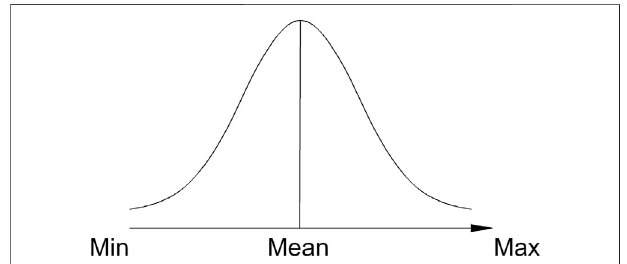
FIGURE 4 | Representation of novelty as a subjective dimension from a minimum (Min) experienced novelty to a maximum (Max).